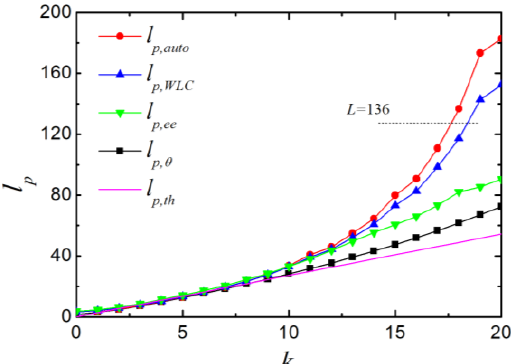
Figure 4. The persistence lengths as a function of bending constant k . l p,auto , l p,WLC , l p,ee and l p, θ are persistence lengths calculated according to the orientation correlation function, the mean square end-to-end distance of a worm-like chain, the projection of the end-to-end vector on the first bond and the bond angle, respectively. The contour length L of the chain is 136.